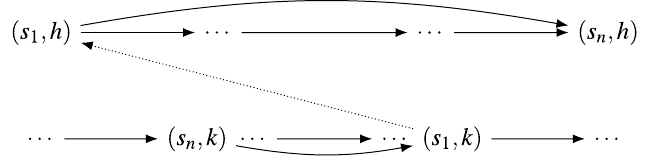
Figure 7. Sketch of Theorem 5.1: assuming no dominated strategies, we pick a strategy h , and label the other players strategies in order s 1 , . . . , s n . By assumption, s n does not dominate s 1 , so we can find other another strategy k where s 1 and s n are reversed. Pick a direction for the arc from ( s 1 , h ) to ( s 1 , k ) (the dotted arc). Requiring there be no MP or CO subgames forces all remaining arcs from ( s i , k ) to ( s i , h ) to be in the same direction; we obtain a contradiction where either h dominates k or k dominates h